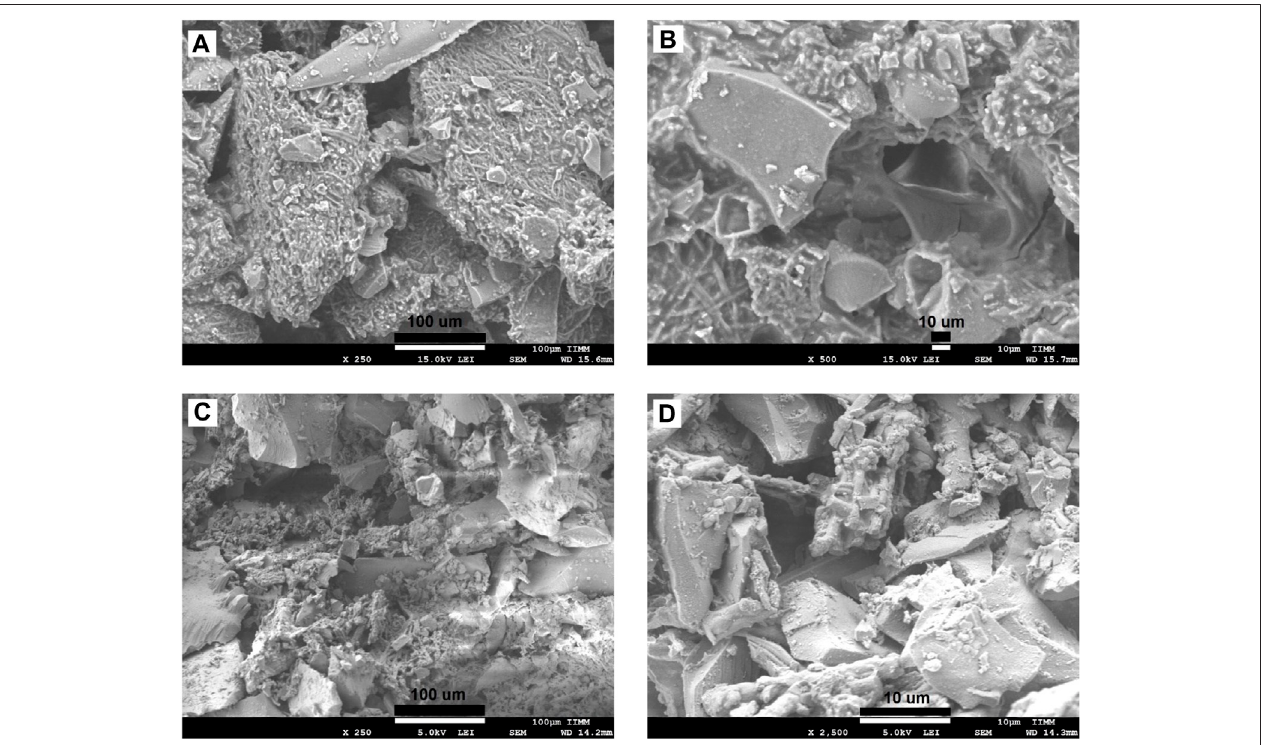
FIGURE 5 | SEM images of the morphology of the SCF-1 at the magni fi cations of: x250 (A) , x500 (B) , and SCF-2 at x250 (C) and x2,500 (D) magni fi cations.